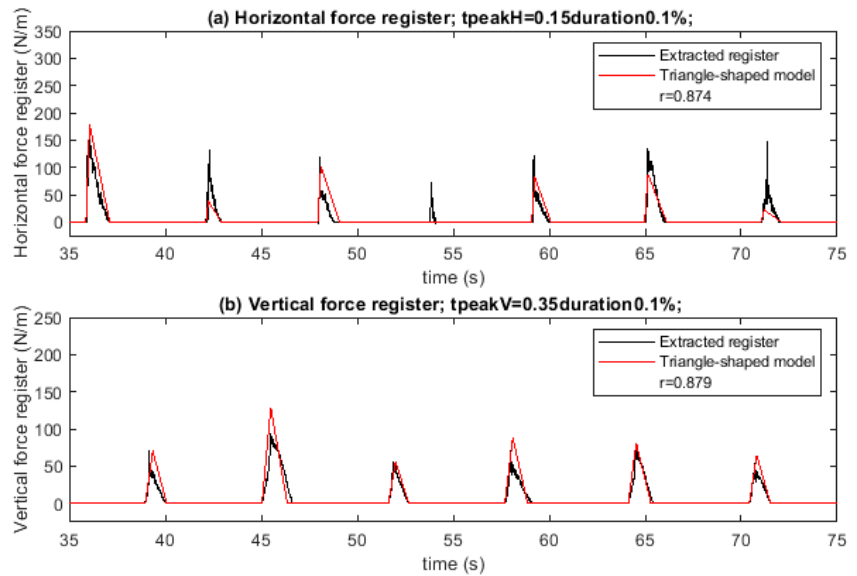
Figure 13. Comparison of Extracted register (the actual maximum force events) and the triangle-shaped model using the estimated F H,0.1% , F V,0.1% , and duration 0.1% for ( a ) horizontal forces and ( b ) vertical forces.